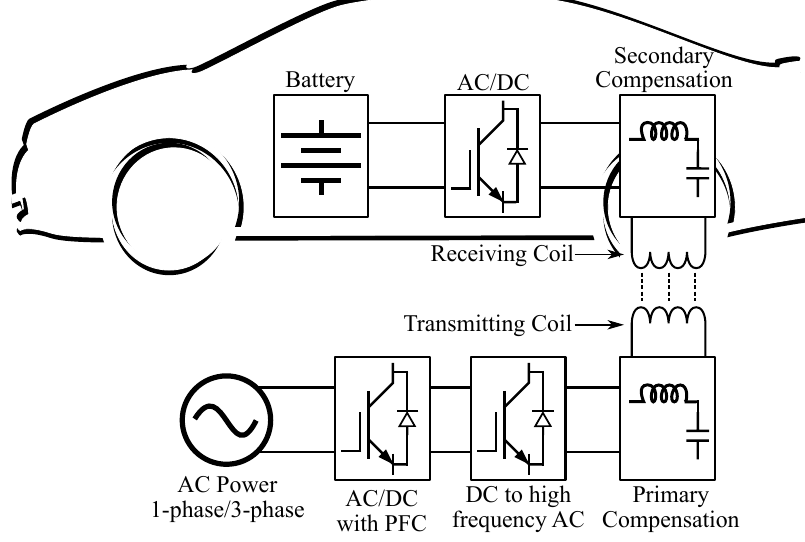
Figure 3. Wireless Charging system